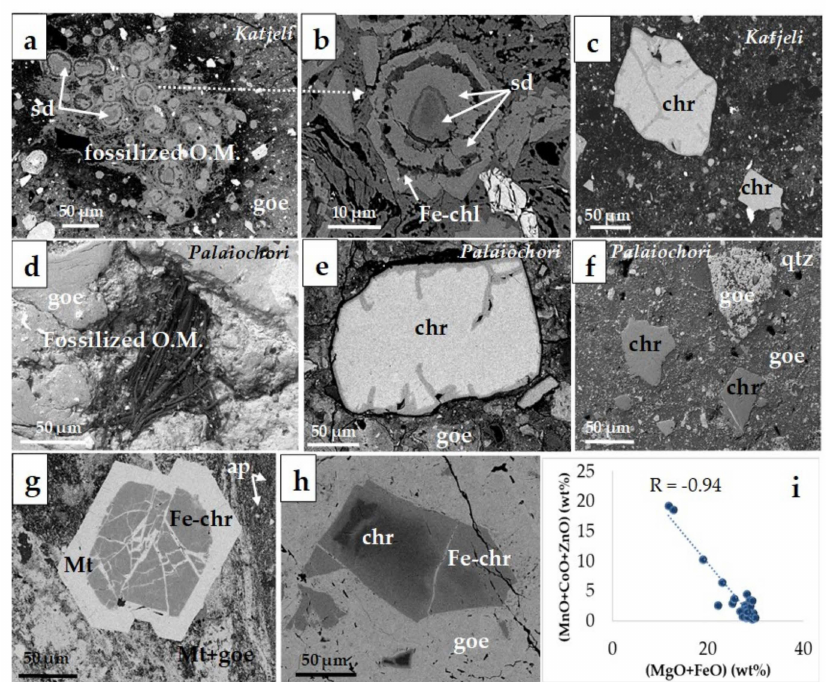
Figure 5. Selected BSE images showing fossilized organic matter and different morphological forms of goethite and/or siderite in Fe–Ni laterite ore from the Palaiochori and Katjeli deposits ( a , b , d ); very limited alteration zone along cracks and peripheral parts of chromite from the Palaiochori and Katjeli deposits ( c , e , f ); apatite in the ores from Edessa ( g ); magnetite and Fe-chromite surrounding chromite cores ( g , h ); a negative correlation between (MnO + CoO + ZnO) content versus (FeO + MgO) content ( i ) data from [19]. Abbreviations: ap = apatite; Fe-chl = Fe-chlorite; O.M. = organic matter; mt = magnetite; as in Figure